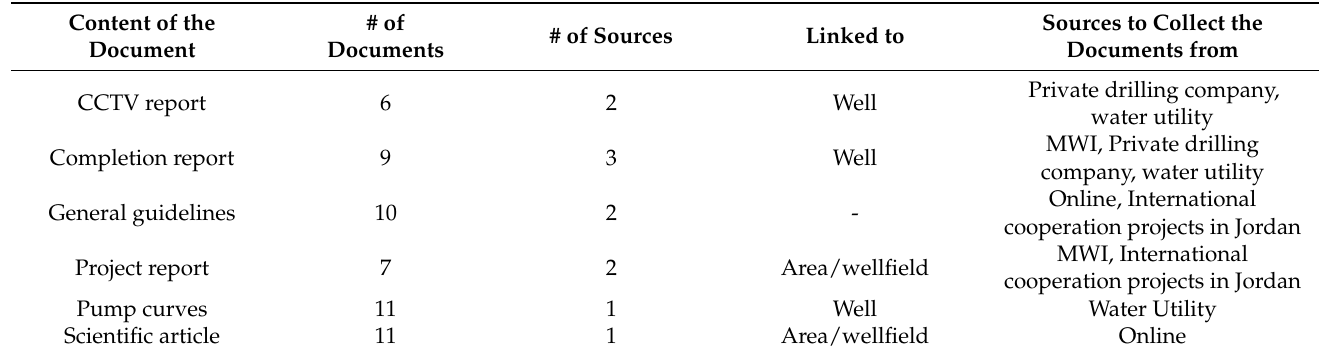
Table 1. An overview of the included documents in DeMa and the sources of the